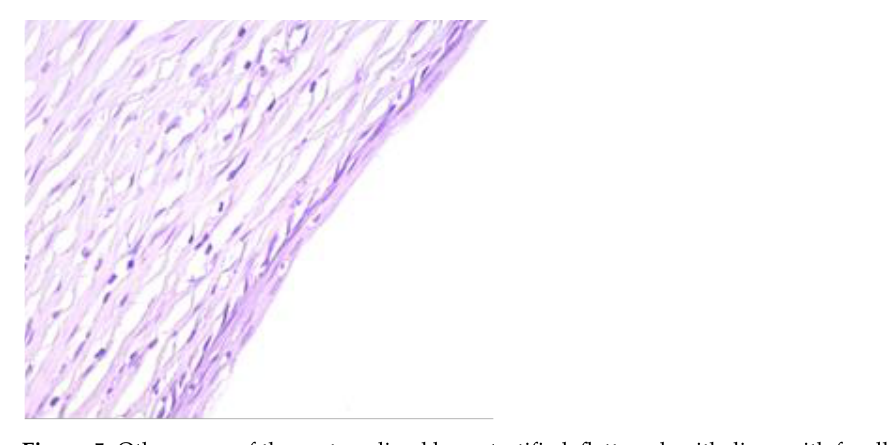
Figure 5. Other areas of the cyst are lined by a stratified, flattened epithelium with focally outer fine, but distinct, granulated eosinophilic cytoplasm cells (HE staining, 40 × ).